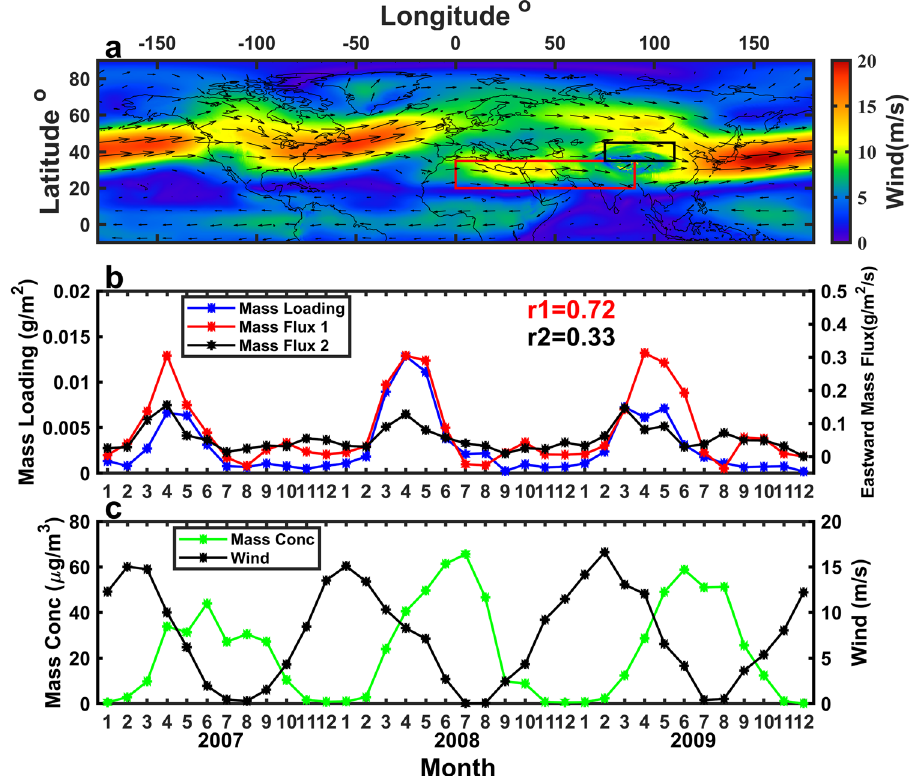
Fig. 3 The seasonal upper troposphere column (above 6 km above mean sea level (MSL)) dust mass loading, controlled by the seasonal variations of source dust mass concentration (mass conc) and wind. a All season averaged velocity fi eld overlaid by wind vectors averaged between 4 and 6 km MSL. The red box (0° – 90° longitude, 20°N – 35°N latitude) represents major Africa – West Asia dust source regions under the in fl uence of the westerly jet, and the black box (75° – 110° longitude, 35°N – 45°N latitude) covers East Asia dust source regions. b Monthly upper troposphere column dust mass loading (blue line) averaged north of 30°N latitude, and monthly eastward dust mass fl ux averaged between 4 and 6 km MSL in the red box (1) and black box (2). The mass fl ux 1 (red line) is associated with r1 and the red box in Fig. 3a, and the mass fl ux 2 (black line) is associated with r2 and the black box in Fig. 3a. c Monthly dust mass concentration (green line) and zonal wind (black line) averaged between 4 and 6 km MSL in the red box (Fig.